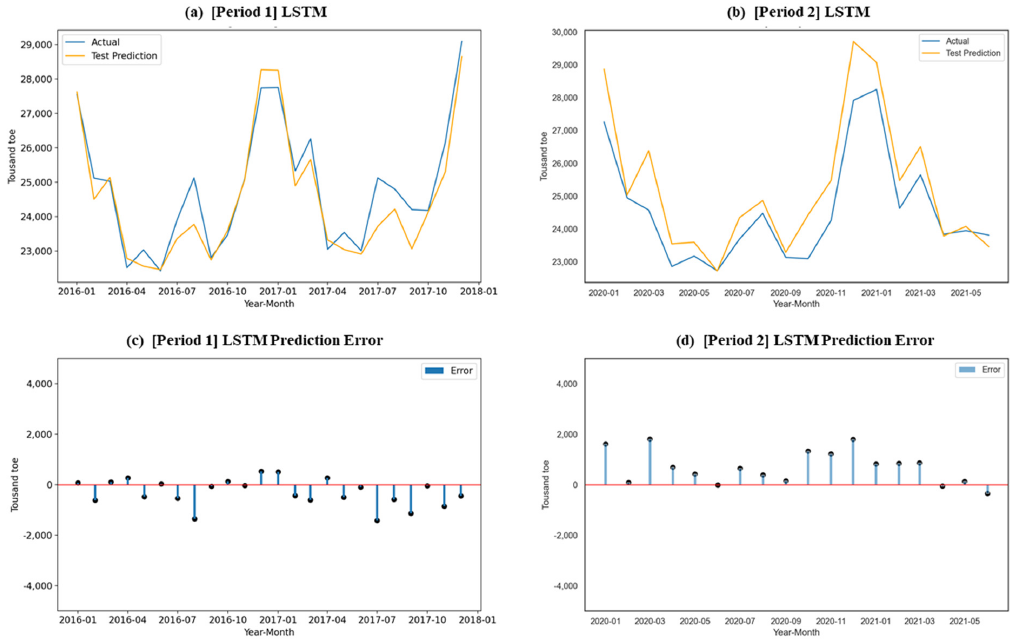
Figure 11. LSTM model comparison by period with prediction error.